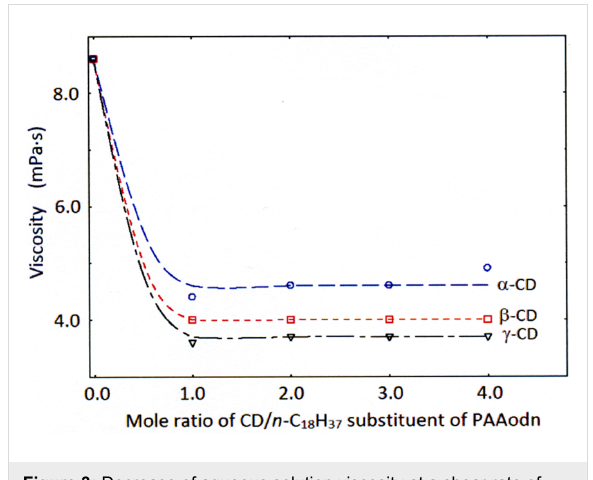
Figure 3: Decrease of aqueous solution viscosity at a shear rate of 50 s − 1 due to α -CD (circles), β -CD (rectangles) and γ -CD (triangles) host–guest complexation of n -C 18 H 37 substituents competing with n -C 18 H 37 hydrophobic interactions in the randomly substituted poly(acrylate), PAAodn, 0.5 wt % aqueous solution (0.10 M NaCl, pH 7.0). Adapted with permission from [46]. Copyright (2008) American Chemical